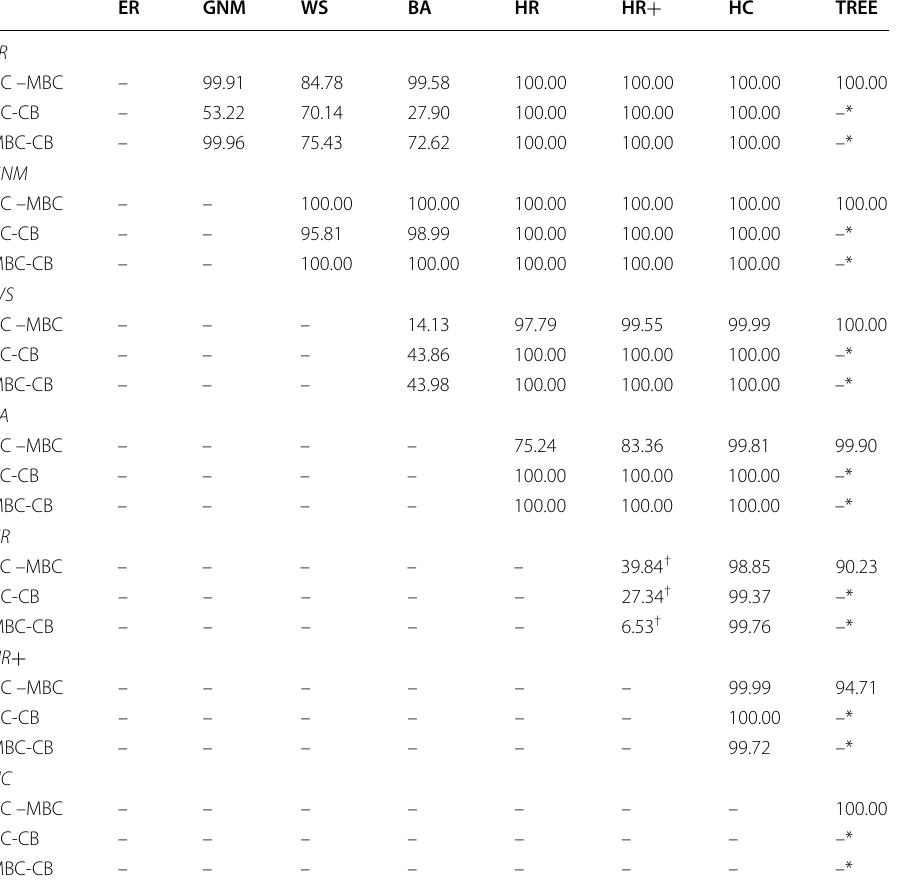
Results in the top-right quadrant show the results comparing hierarchical to non-hierarchical networks. A value of 100 indicates no overlap between the distributions, 0 indicates the distributions are identical. *Values cannot be computed as TREES have zero cycle basis resulting in invalid